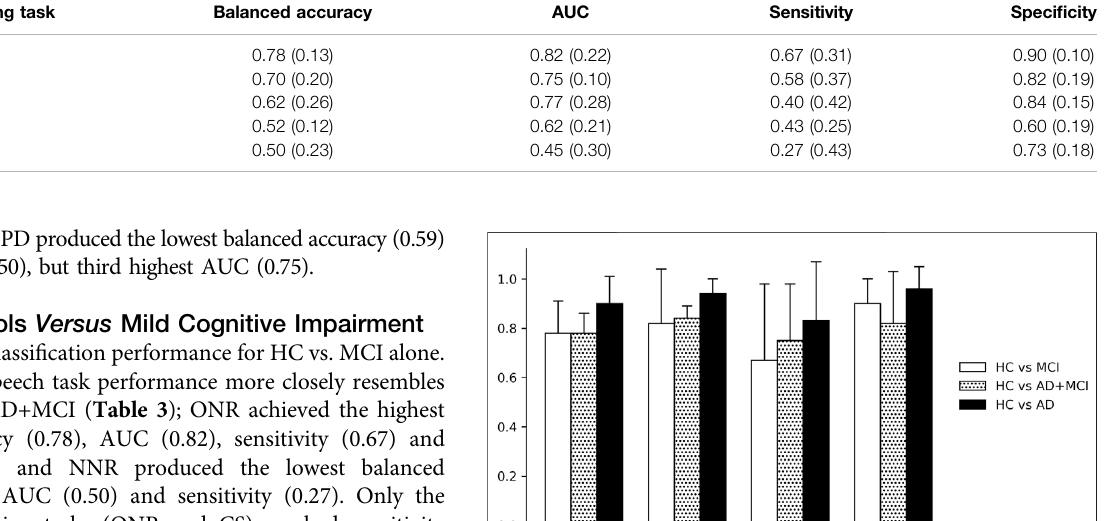
TABLE 7 | HC vs. MCI mean (s.d) SVM classi fi cation performance across fi ve-fold cross-validation for fi ve connected speech tasks, ranked by accuracy. Discourse-generating task Balanced accuracy AUC Sensitivity Speci fi city